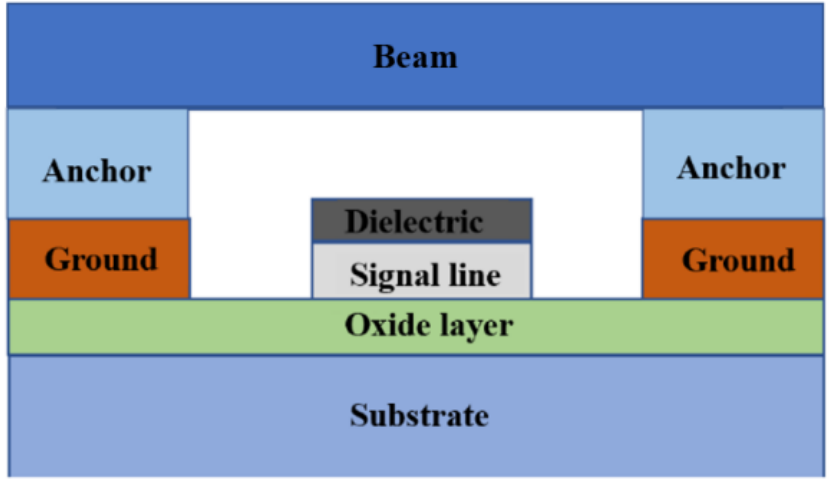
Figure 1. Cross-section of the RF MEMS capacitive shunt switch.